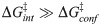
A rugged energy-landscape with hierarchical structure and an emergence of multiple time scales of transitions.τint is the transition time between different superbasins of attraction whereas τconf is the time scale of conformational dynamics of molecule within each basin. Due to large difference in kinetic barriers (ΔGint‡≫ΔGconf‡), τint ≫ τconf.